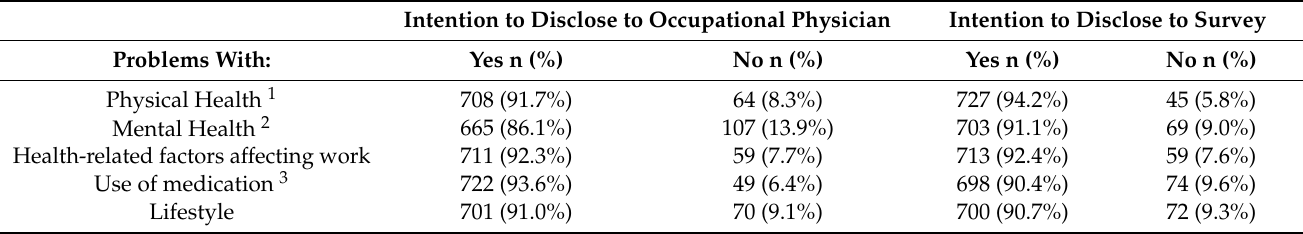
Table 2. Incidence of disclosure to occupational physician and survey by occupational health problem (N = 776).